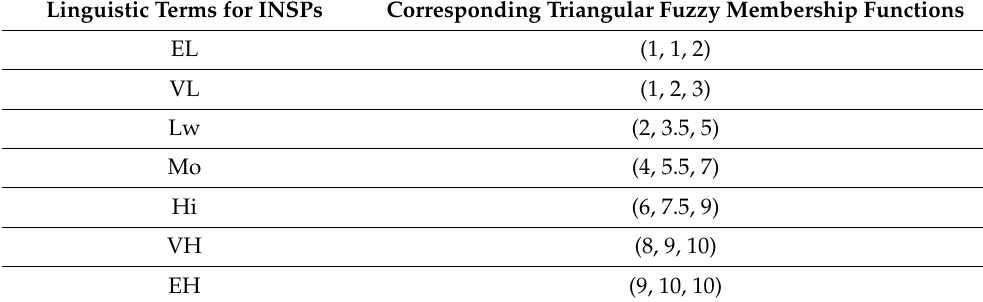
Table 4. Term sets and membership functions for node selection possibilities.